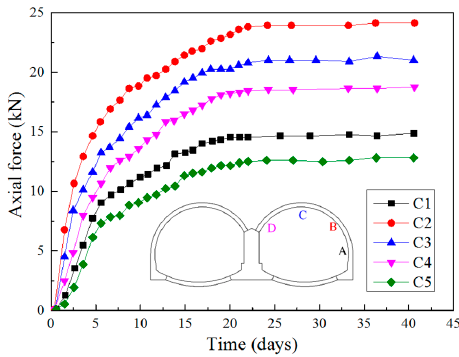
Figure 17. Time history plots of the axial forces in rock bolts at location C in the K89+729 section.